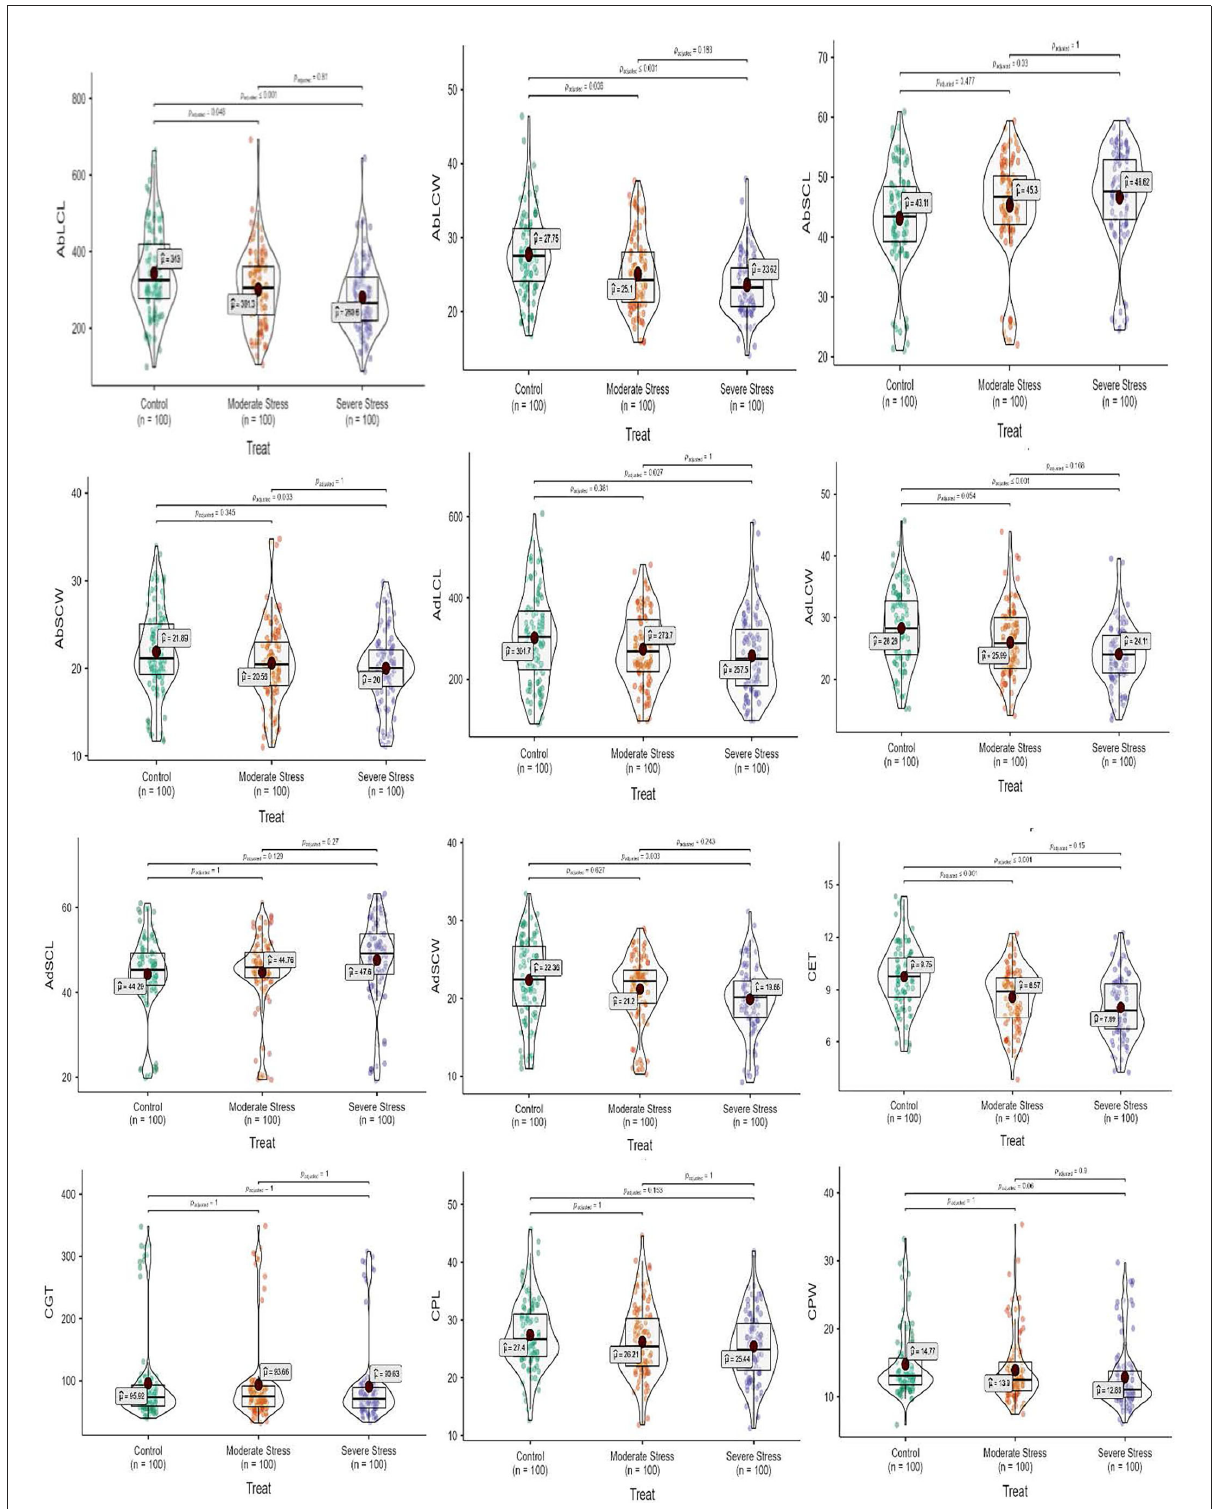
FIGURE2 Box-violin plots presenting leaf epidermal (abaxial and adaxial surface) and culm anatomical features under control (C), moderate (MS), and severe (SS) water stress conditions. The interquartile range is depicted by the length of the boxes, the median by the horizontal line within the box, the mean by the red diamonds within the box, and the probability density of the data at different values by the widths of the violin